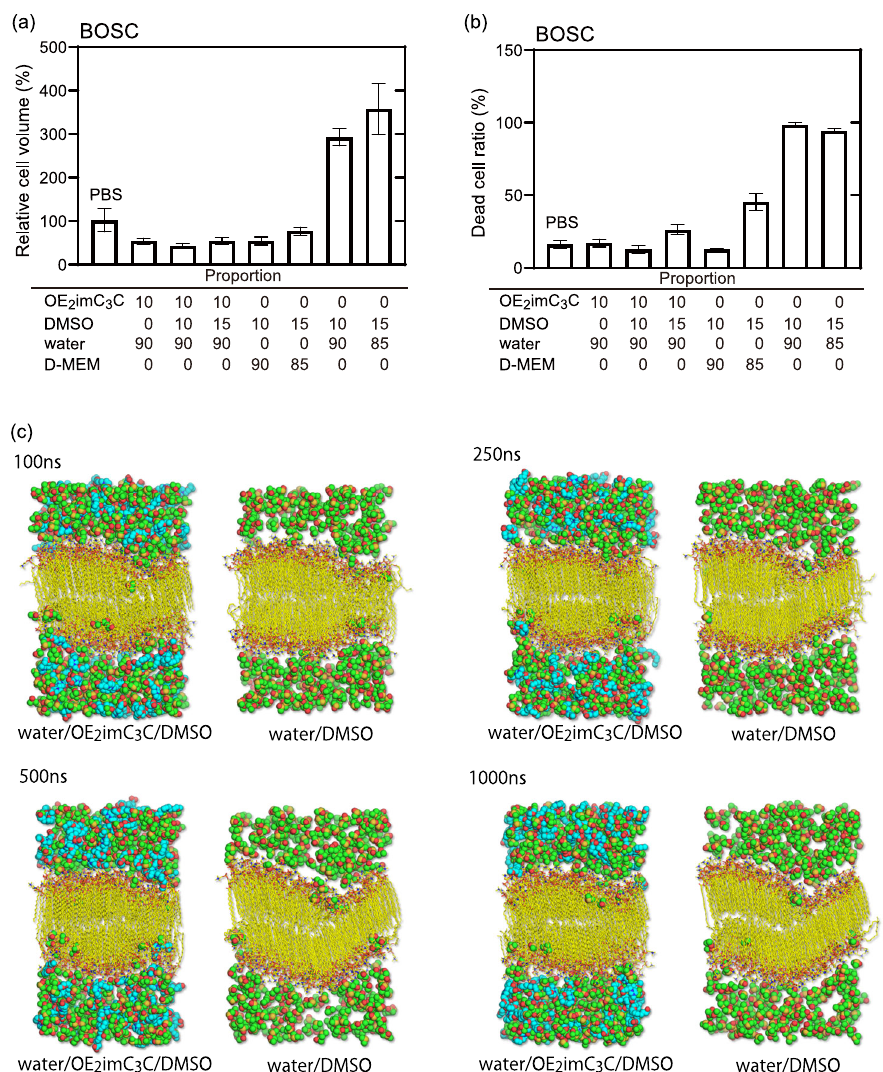
Fig. 6 Cryoprotecting mechanisms of zwitterion/DMSO-containing freezing media. a Relative BOSC cell volume after 5 min of immersion in the indicated solutions (cell volume in PBS was standardized as 100%). Total compositions in some cases are over 100 to be clear. b Dead BOSC cell ratio after 60 min of immersion in the indicated solution ( n = 3, biologically triplicate). a and b The cells were immersed as fl oating cells in the solutions at room temperature after trypsinization. The bars show standard error. c Images of the cell membrane in the water/OE 2 imC 3 C/DMSO and water/DMSO mixtures at 100, 250, 500, and 1000ns, as calculated by molecular dynamics simulations with Lipid17 force fi eld. The reproducibility was con fi rmed by the calculation with Lipid14 force fi eld (Fig.